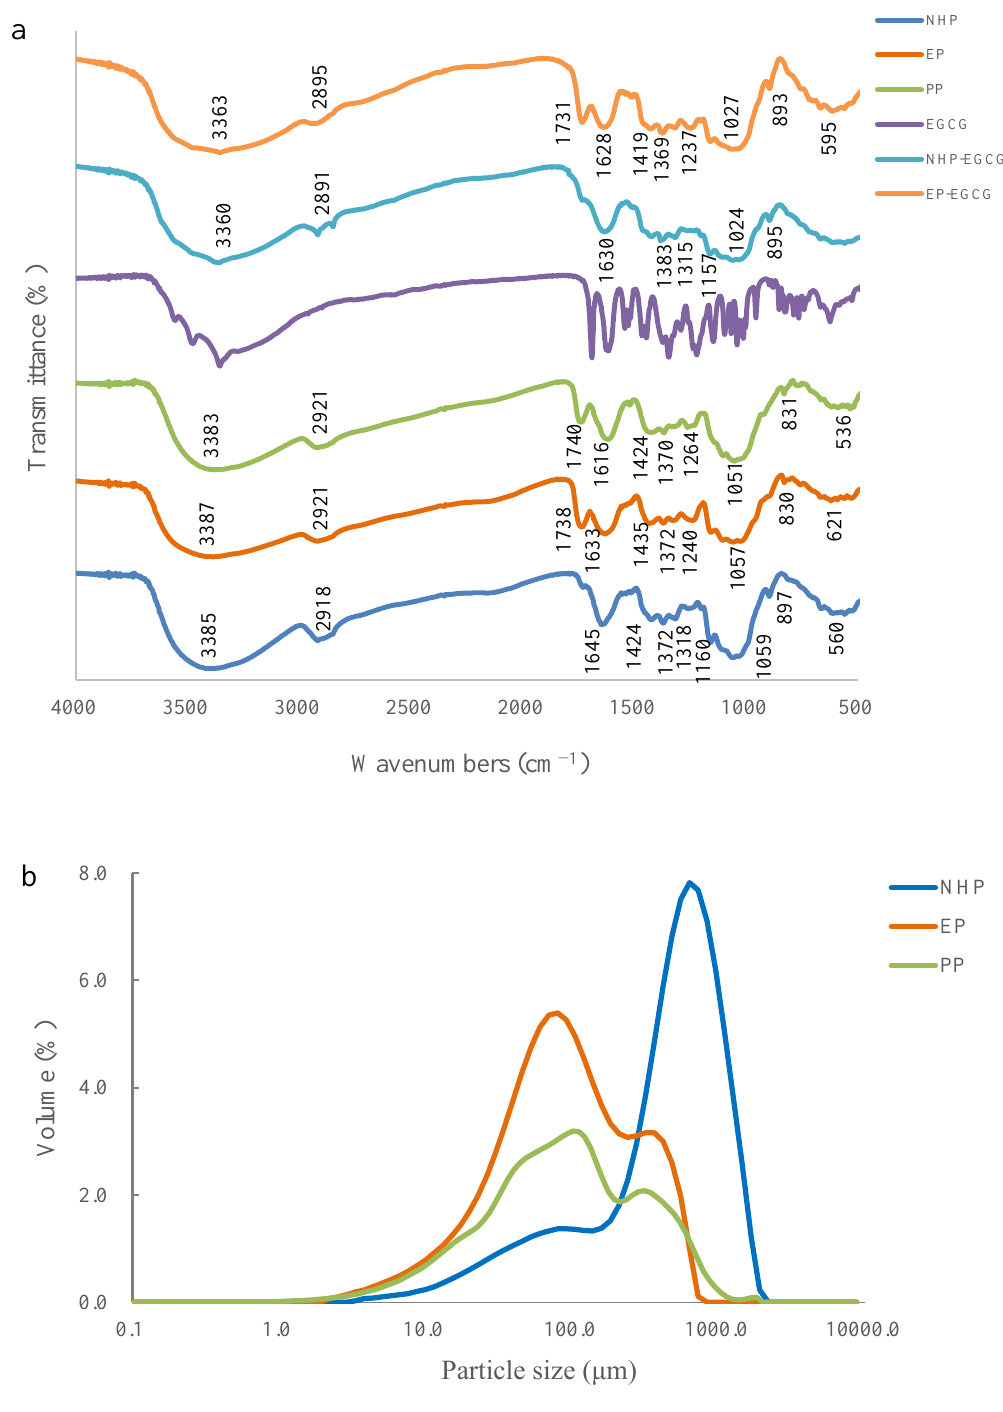
Figure 1. FTIR spectra of PP, NHP, EP pomelo peel samples, EGCG powder, and NHP, EP after adsorption ( a ). The particle size distribution of NHP, EP and PP peel sample ( b ). The curves of untreated pomelo peel (PP) in FTIR and particel size distribution results were re-drawn from our previous result in reference